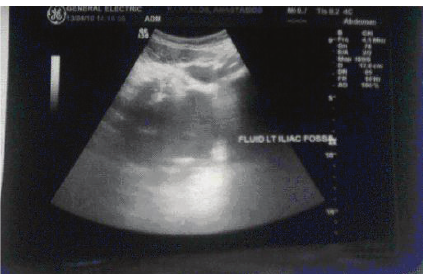
Figure 2: Abdominal ultrasound showed splenomegaly (17,27 × 8,7cm) and free fluid in the left iliac fossa.